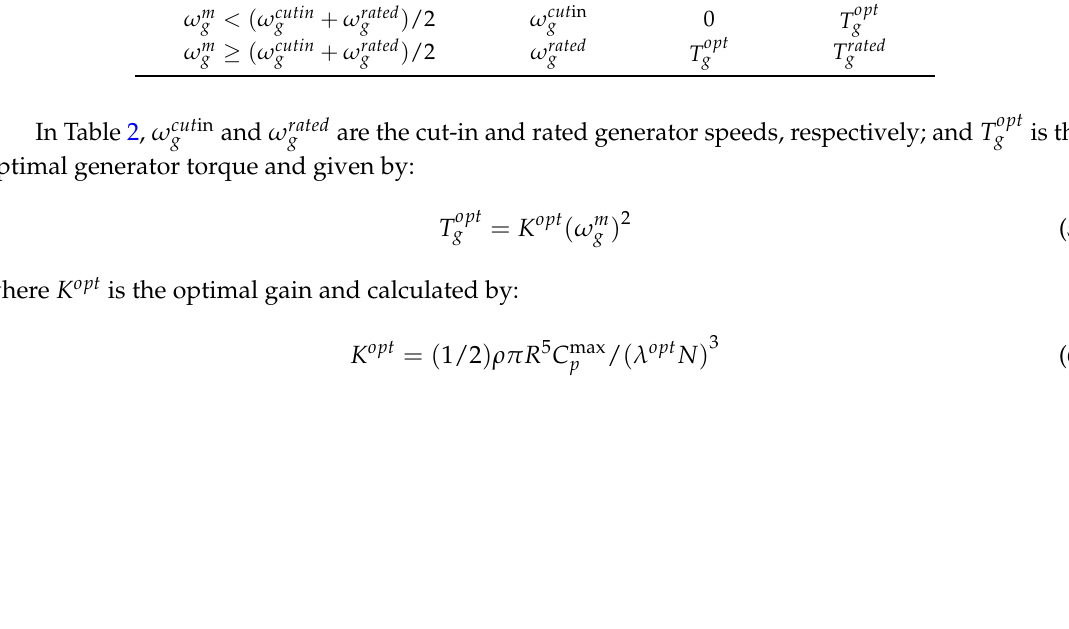
Table 2. Control rule of the mode selection unit.